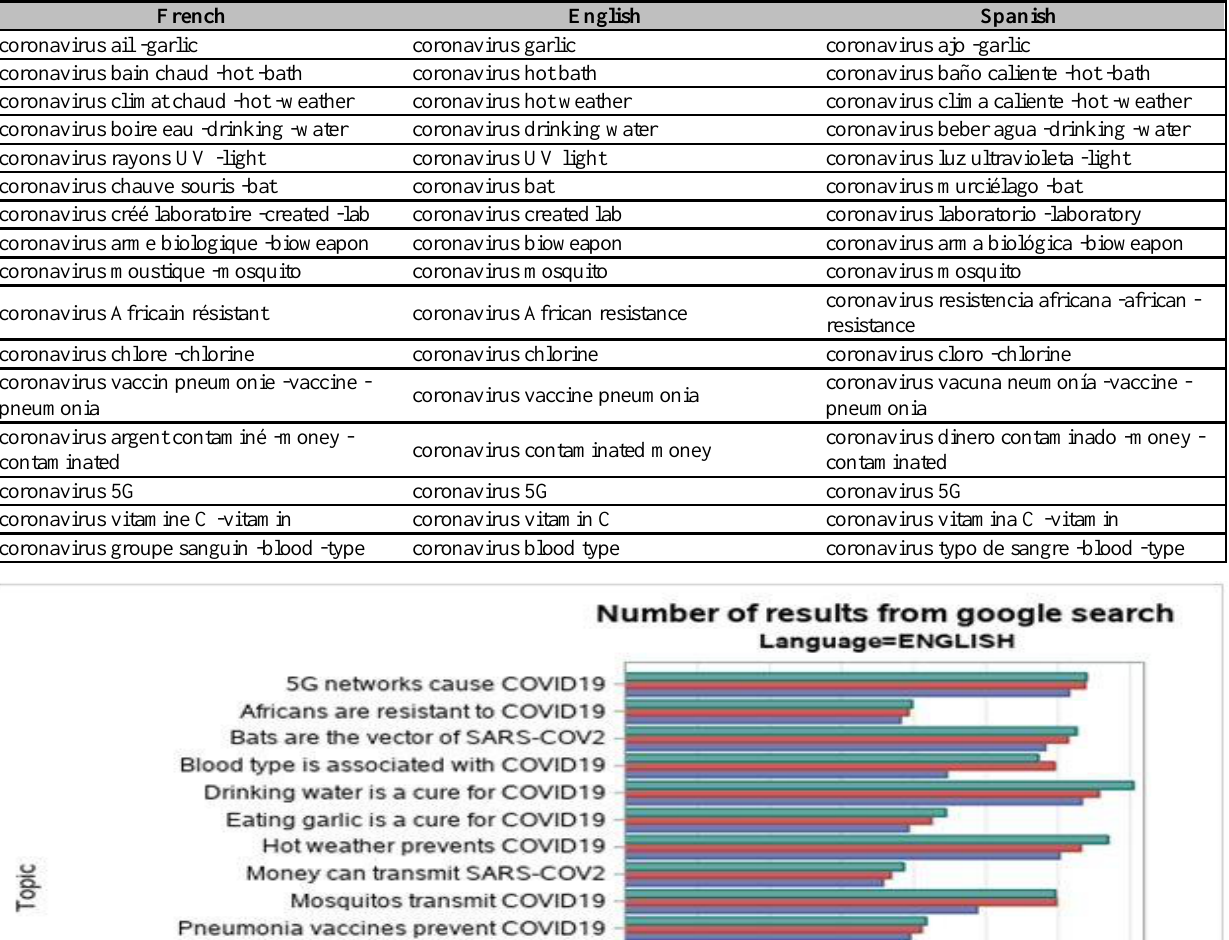
Table 2. Summary of keywords used in the Google search